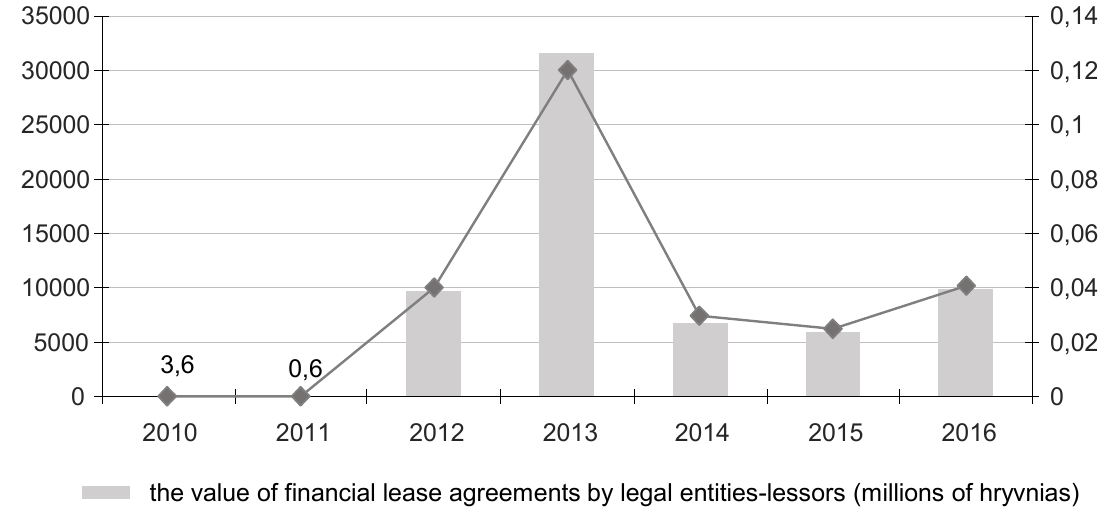
Figure 1. Dynamics of performed financial leasing transactions in Ukraine